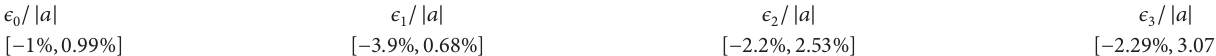
Table 2: Ranges of the parameters of perturbations at 3𝜎 level.